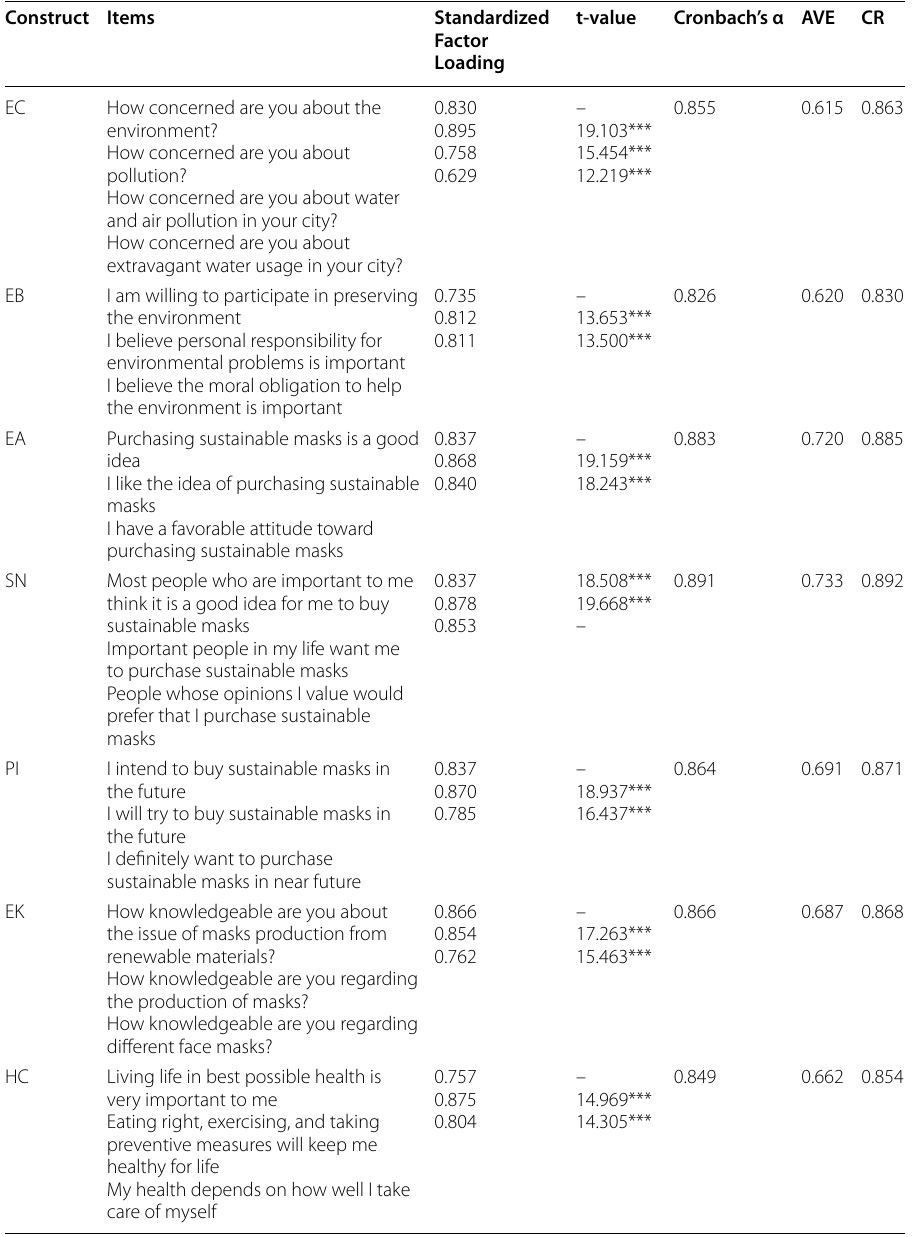
Table 2 Results of measurement